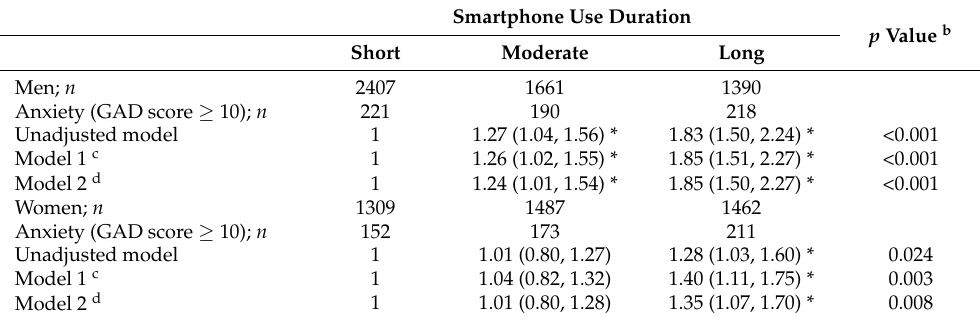
Table 3. Sex-stratified analysis for the relationship between smartphone use duration and anxiety a